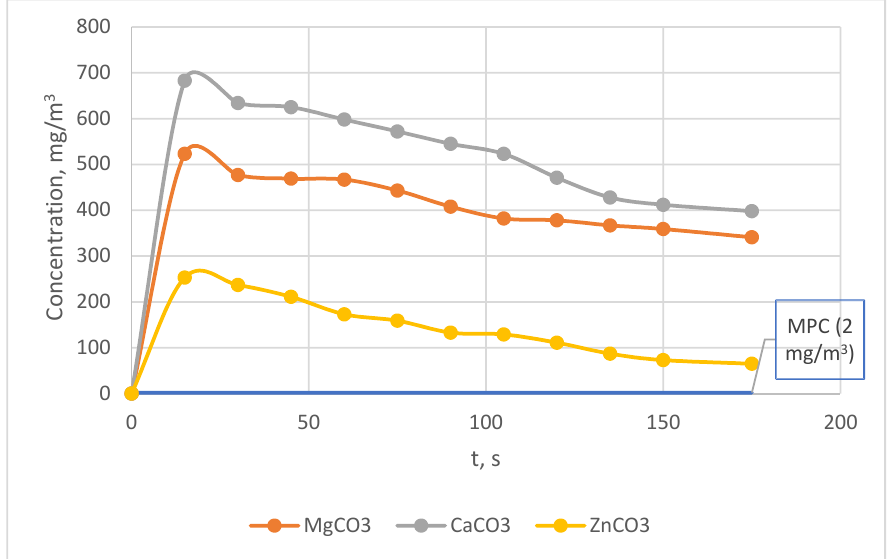
Figure 5. Dependence of the concentration of nitrogen oxides in the explosion products on the filler used (compiled by the author R.S. Babkin).